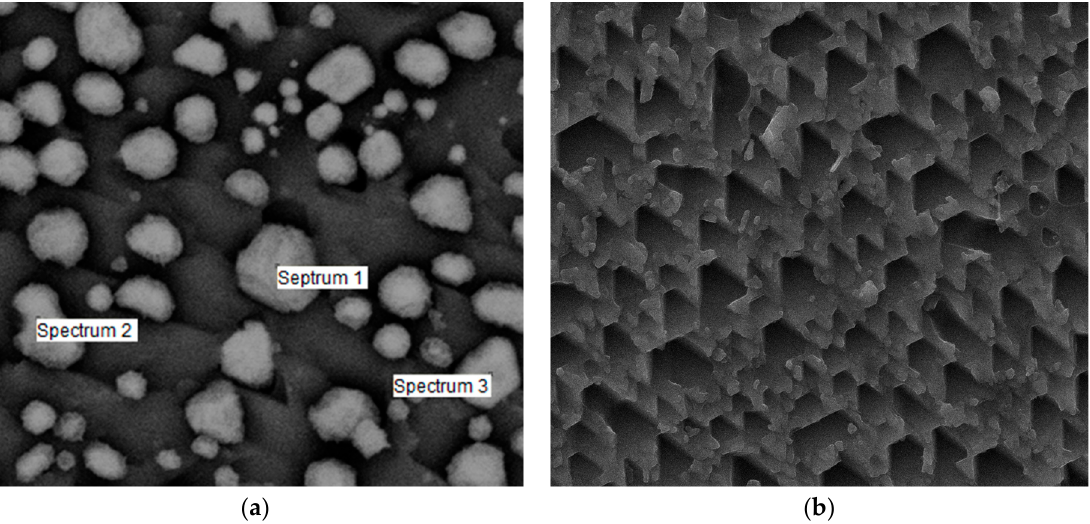
Figure 5. Backscattered electron SEM micrographs of the globules observed on the surface of a chromite particle reduced at a hydrogen flow rate of 150 mL/min ( a ) and a similar surface after acid leaching ( b ).